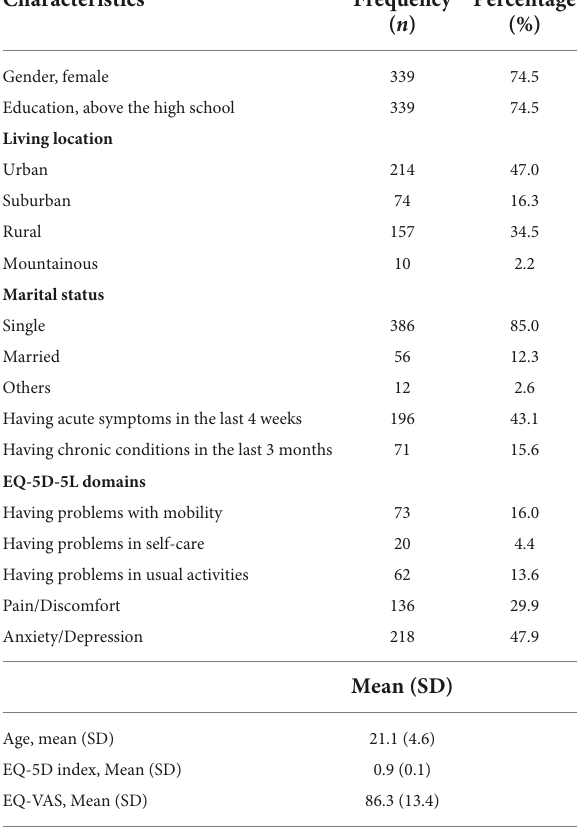
TABLE 1 Socio-demographic and health status characteristics of respondents.